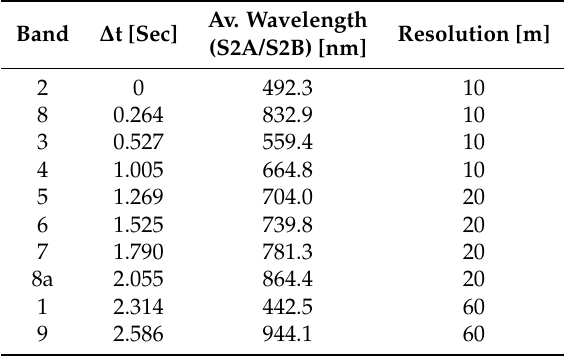
Table 1. Detector bands Sentinel-2: visible and near-infrared [27].